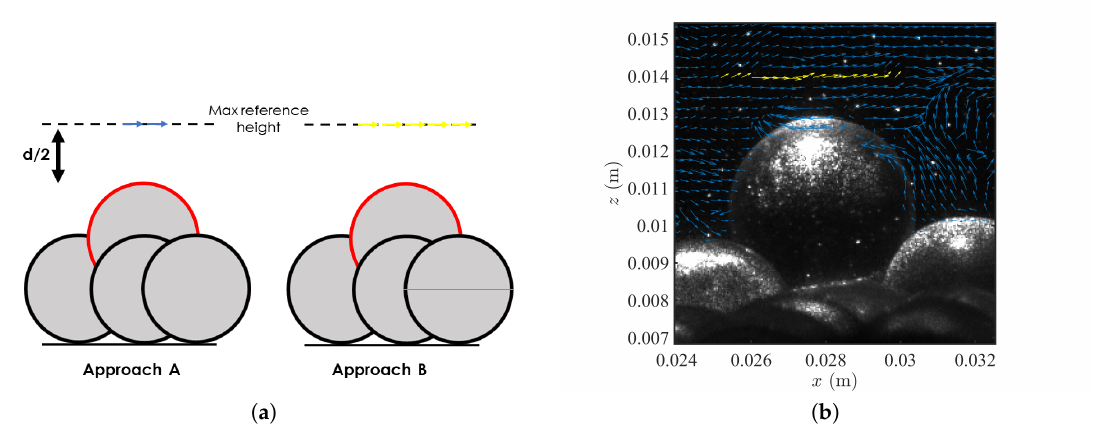
Figure 2. ( a ) Scheme of the velocity vectors considered in the spatial average in approach A and B ; velocity vectors averaged in approach A are reported in blue, while those averaged in approach B in yellow. ( b ) PIV image with velocity vectors superimposed; velocity vectors averaged in approach B are reported in